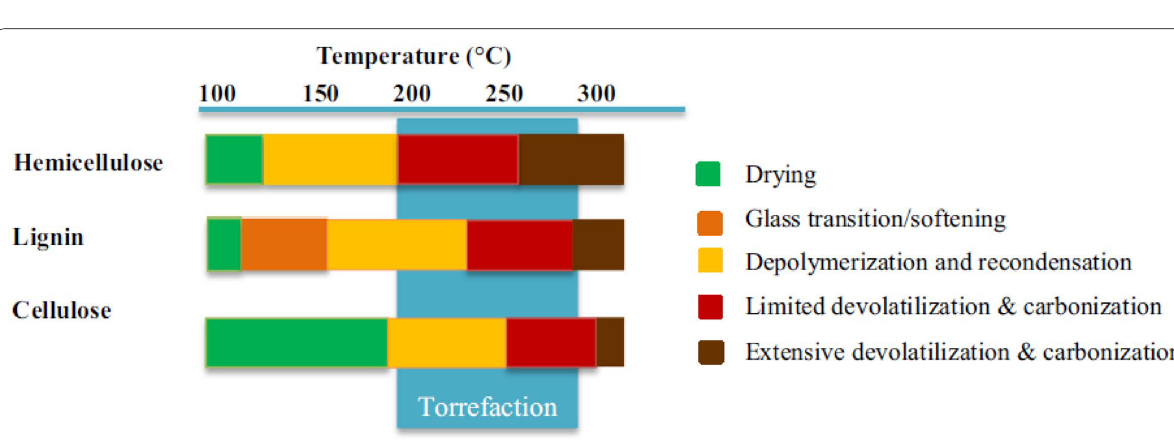
Fig. 2 Reaction of biomass components at different torrefaction temperatures (Christoforou and Fokaides,